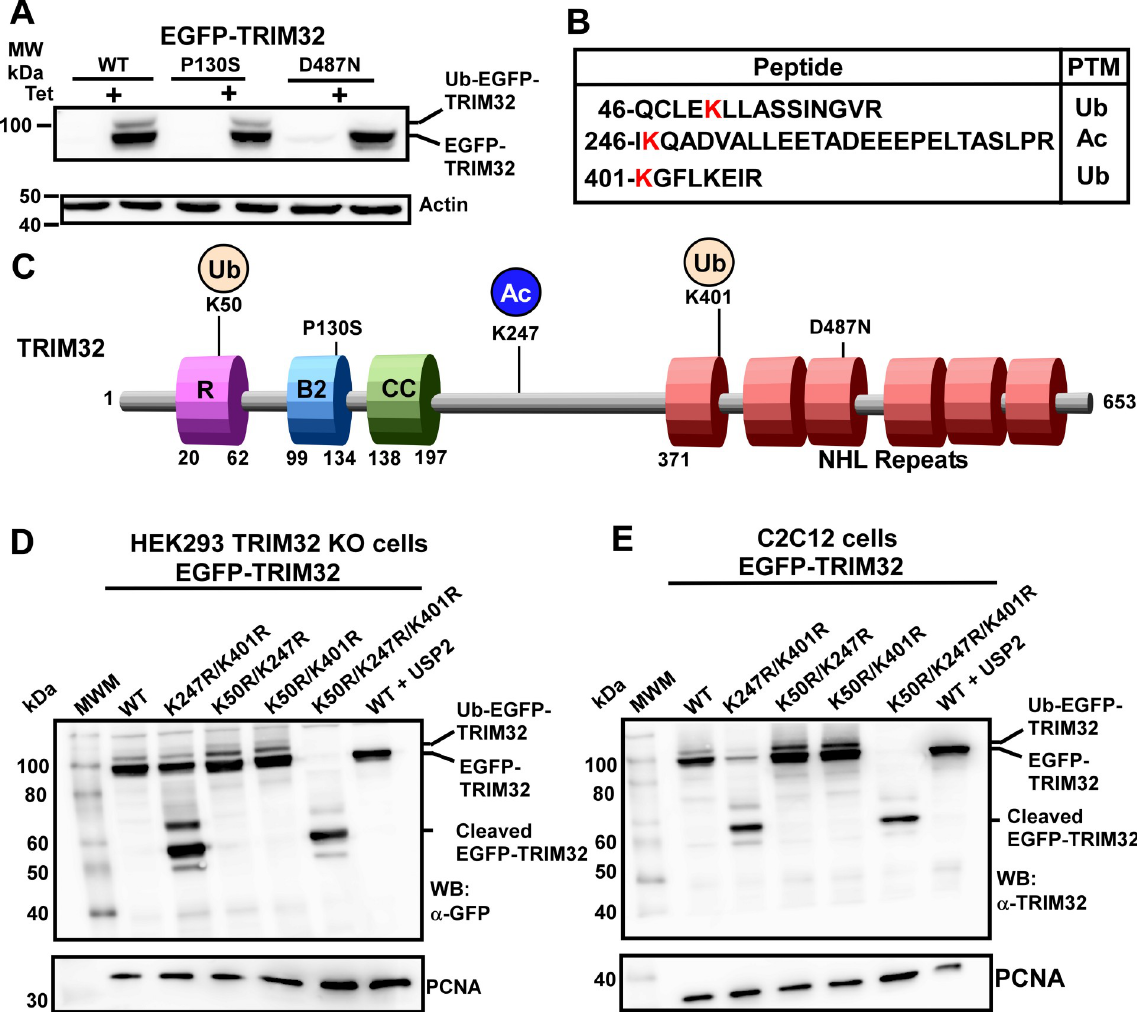
Fig 1. PTMs of TRIM32 K50 , TRIM32 K247 and TRIM32 K401 regulate its cleavage. (A) Western blot analysis of cell extracts from HEK293 FlpIn cells with tetracycline inducible expression of EGFP-TRIM32 WT , the BBS11 associated mutant EGFP-TRIM32 P130S , or the LGMD2H causing mutant EGFP-TRIM32 D487N shows auto-ubiquitylation activity of TRIM32 WT and TRIM32 P130S , but not the LGMD2H mutant. (B) Sequence of the TRIM32 peptides identified by MS to display PTMs on lysine residues that differed between the TRIM32 proteins with auto- ubiquitylation activity (TRIM32 WT and TRIM32 P130S ) and the LGMD2H disease variant lacking auto-ubiquitylation activity (TRIM32 D487N ). (C) Schematic of TRIM32 domain organization. The D487N mutation in the NHL repeats that is associated with LGMD2H and the P130S mutation in the B-box causing BBS11 are indicated above. The three lysine residues that are focused in this paper are indicated in red, while the PTMs of these residues identified by MS are indicated above. Ub: Ubiquitylation. Ac: Acetylation (D) Western Blot analysis of HEK293 FlpIn TRIM32 KO cells transiently transfected with expression plasmids for EGFP-TRIM32 WT , the double mutants EGFP-TRIM32 K247R/K401R , EGFP-TRIM32 K50R/K247R , or EGFP-TRIM32 K247R/K401R , or the triple mutant EGFP-TRIM32 K50R/K247R/K401R . The last lane represents co- transfection of EGFP-TRIM32 WT and mCherry-USP2 expression vectors. The bands representing EGFP-TRIM32, auto-ubiquitylated EGFP-TRIM32, and cleaved EGFP-TRIM32 are indicated to the right. PCNA represents the loading control. (E) Western blot analysis of a similar experiment as in (D), except that the myoblast C2C12 cell line is used instead of the HEK293 FlpIn TRIM32 KO cell line, and the antibody used is an anti-TRIM32 antibody instead of an anti-GFP antibody.